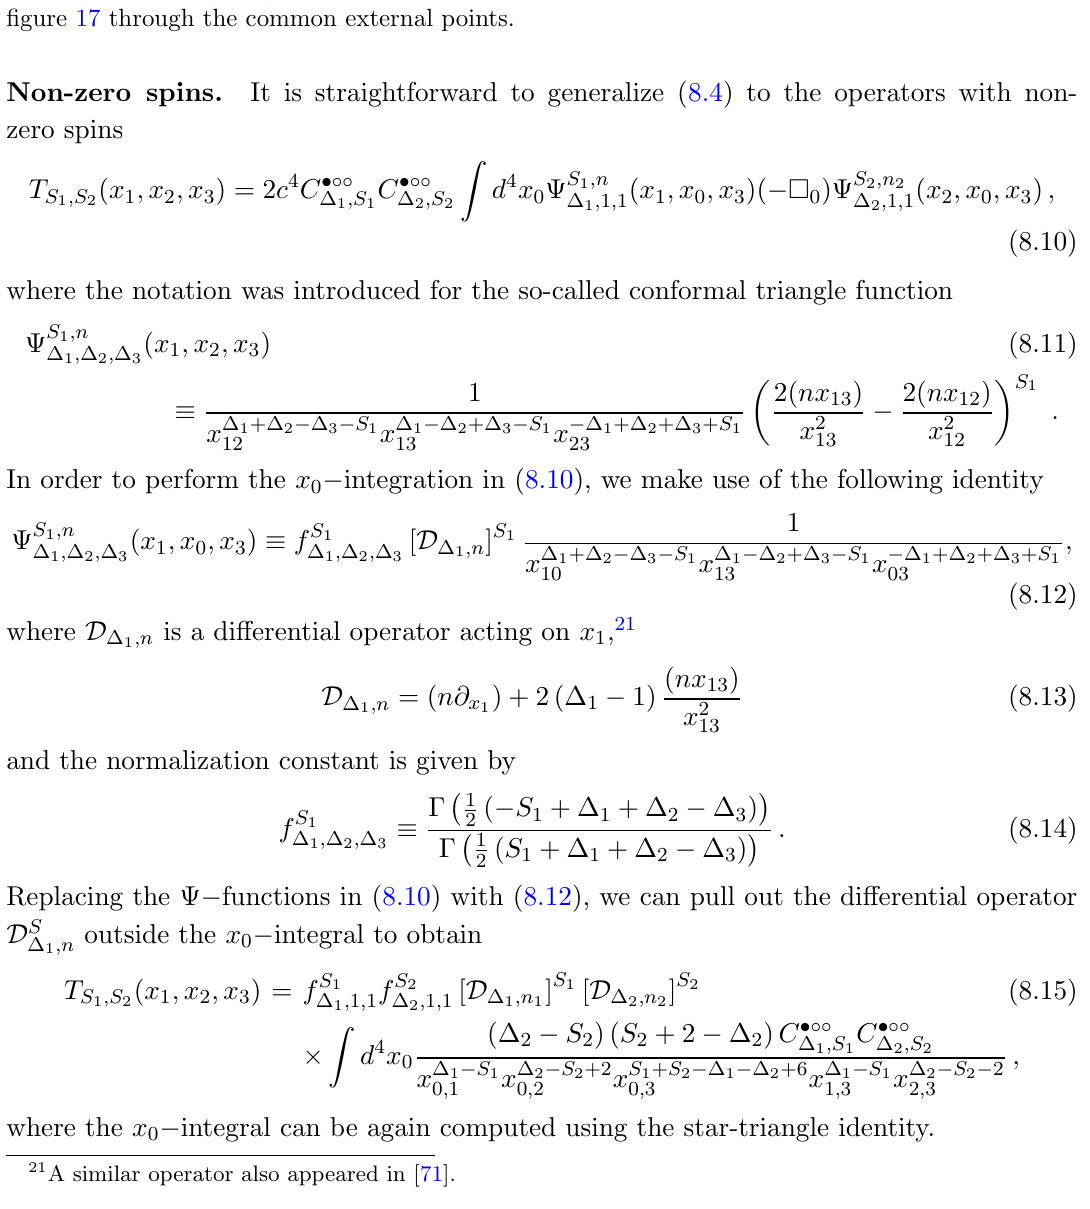
Figure 18 . Three-point correlation function of two unprotected twist-2 operators and one pro- tected operator tr( X (cid:22) X ). It can be obtained by gluing together two wheel diagrams shown in (cid:12)gure 17 through the common external